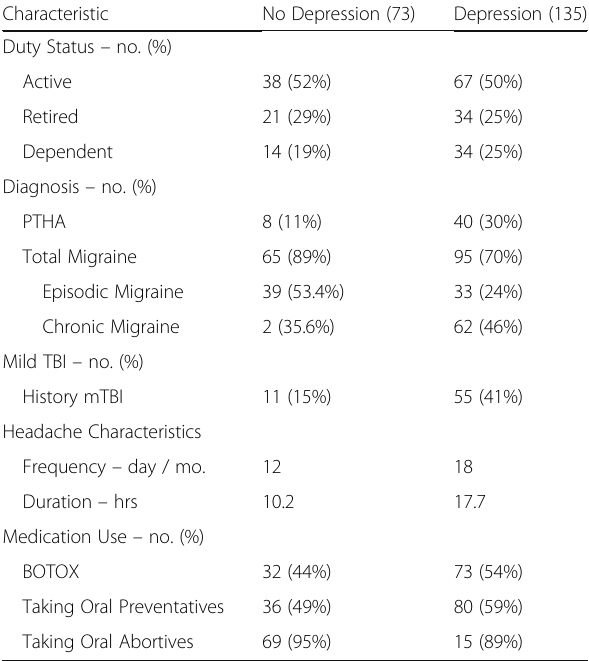
Table 1 Patient demographics. A comparison of duty status, headache diagnosis, TBI history and medication use in patients who screened positively versus negatively for depression